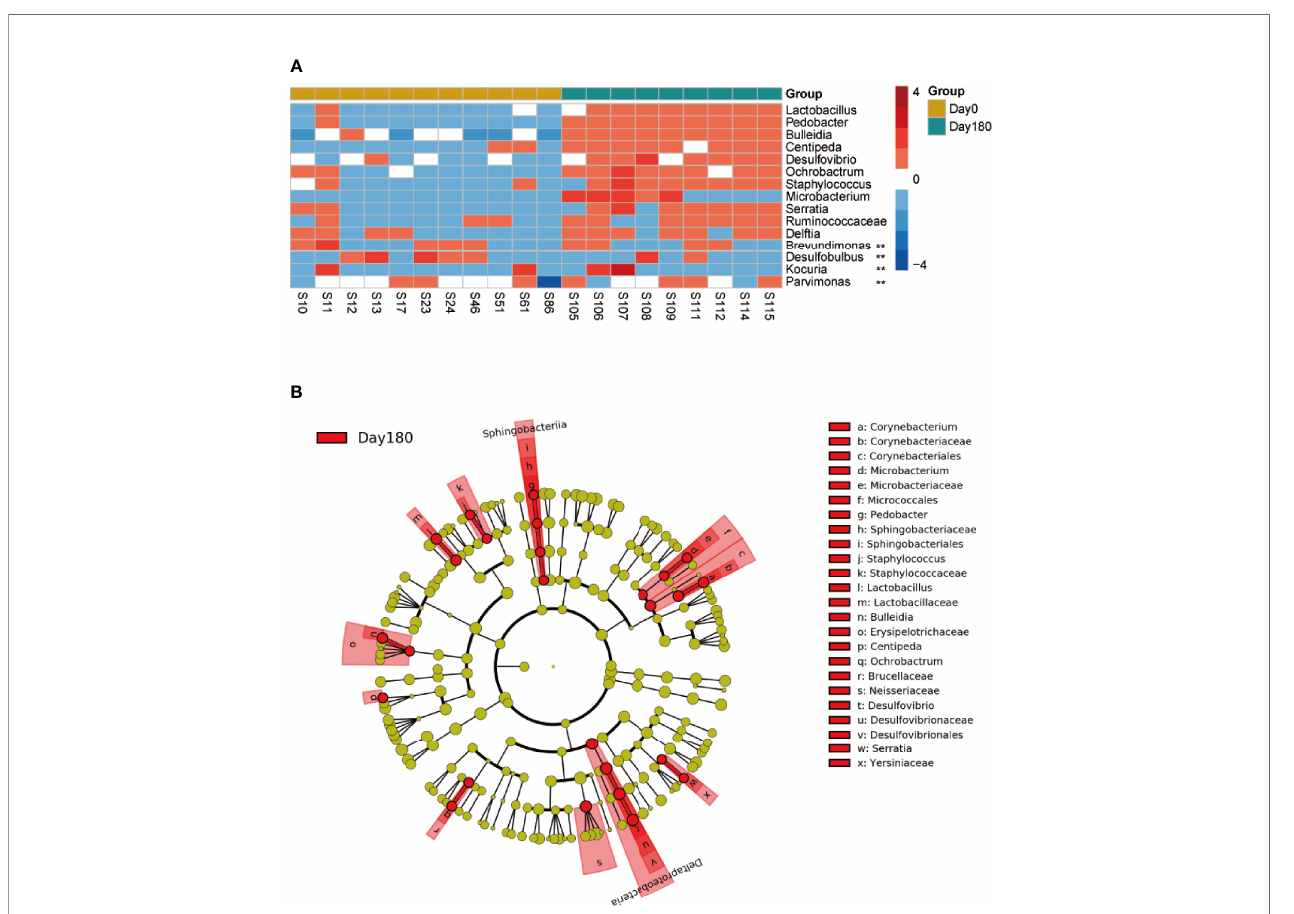
FIGURE 5 | Different taxa between the pre-treatment group (day 0) and the 180 days after-treatment group. (A) Signi fi cantly different genera of day 0 compared with the 180 days after-treatment group. Wilcoxon rank-sum test with false discovery rate correction ( P < 0.05, **). (B) Taxonomic LEfSe cladogram obtained using linear discriminant analysis (LDA) effect size (LEfSe) analysis. LEfSe identi fi ed the taxa with the greatest differences in abundance between the 180 days after- treatment group and day 0. Only taxa meeting a signi fi cant LDA threshold value of >2 are